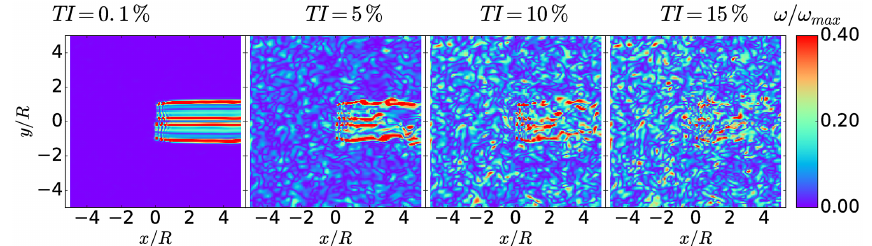
Figure 13. Normalized instantaneous vorticity ω x /ω max of wind turbine wake immersed in HIT for different turbulence intensities.